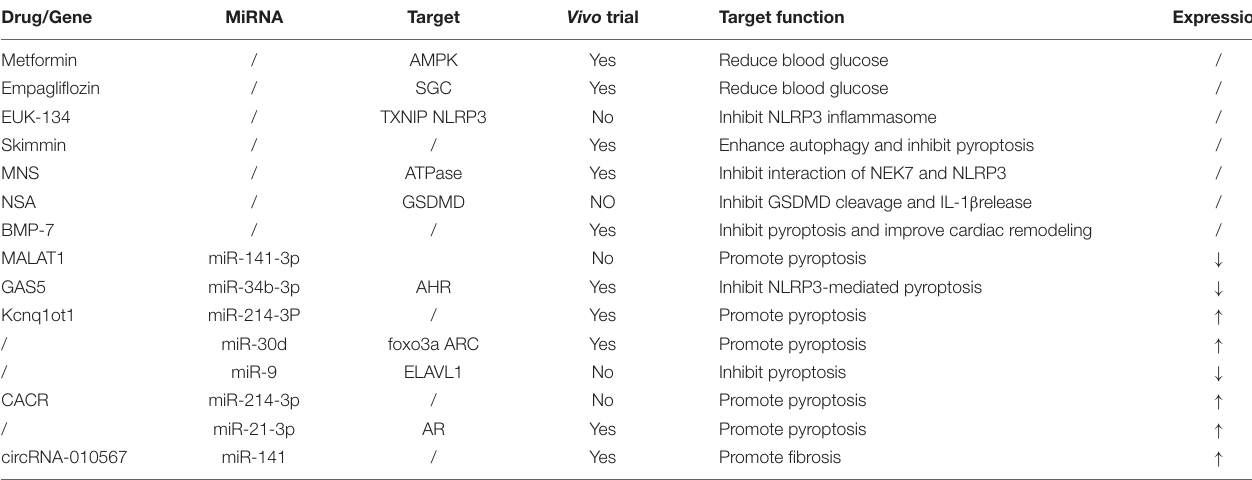
AMPK, AMP-activated protein kinase; MNS, 3,4-methylenedioxy- β -nitrostyrene; TXNIP, thioredoxin interacting protein; BMP-7, bone morphogenetic protein-7; MALAT1, metastasis associated lung adenocarcinoma transcript1; GAS5, growth arrest-specific transcript 5; AHR, aryl hydrocarbon receptor; Kcnq1ot1, KCNQ1 opposite strand/antisense transcript 1; foxo3a, Forkhead box o3; ARC, caspase recruitment domain; ELAVL1, ELAV-like protein 1; CACR, caspase-1-associated circRNA; AR, androgen